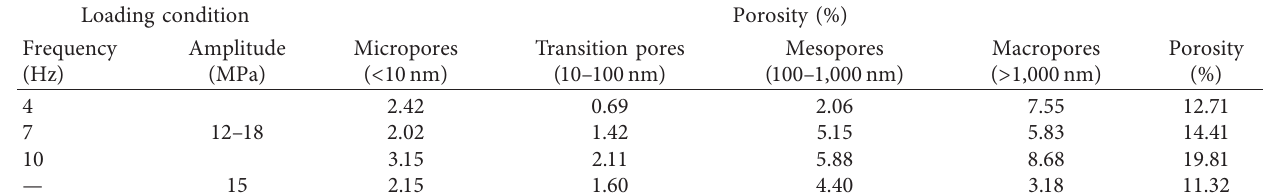
Table 2: Percentages of the pore volume and porosities of coal mass at different loading frequencies.